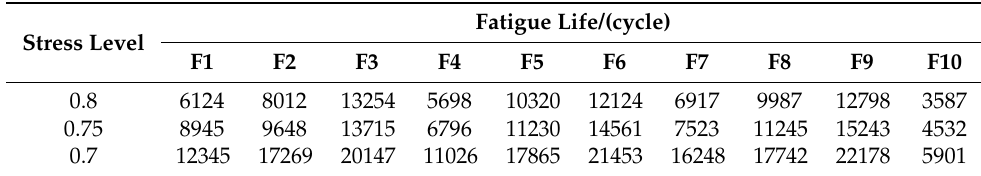
Table 10. Results of the fatigue life.